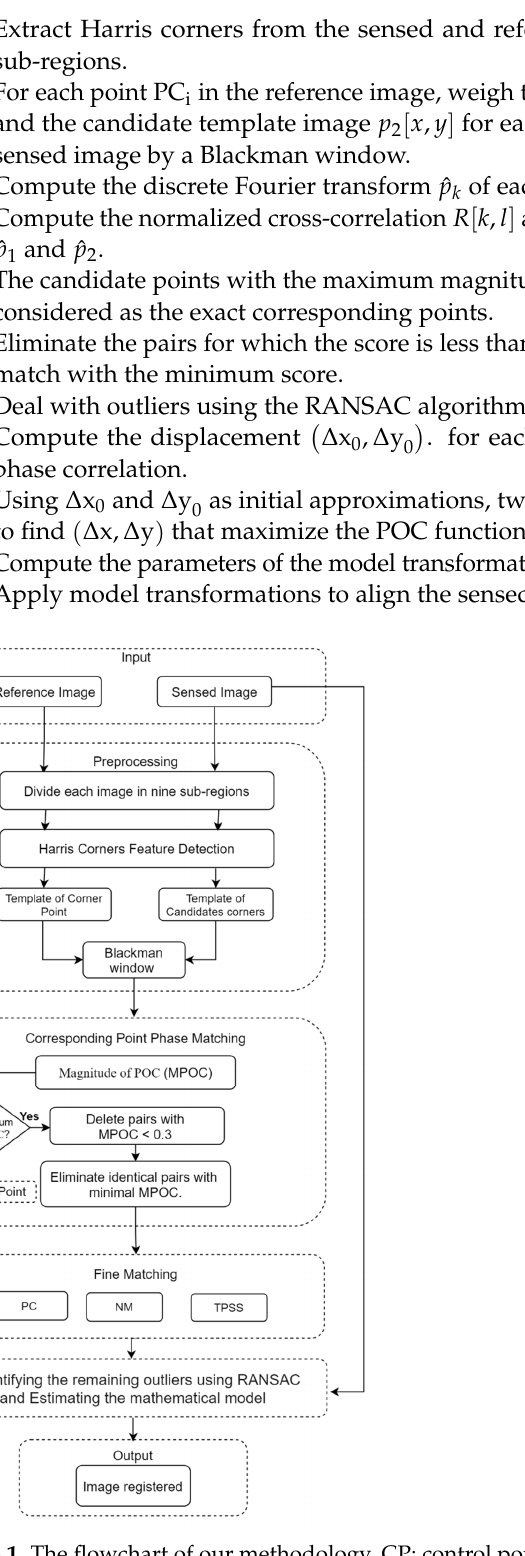
Figure 1. The flowchart of our methodology. CP: control point; DB: database; PC: phase correlation; NM: Nelder–Mead; TPSS: two-point step size.